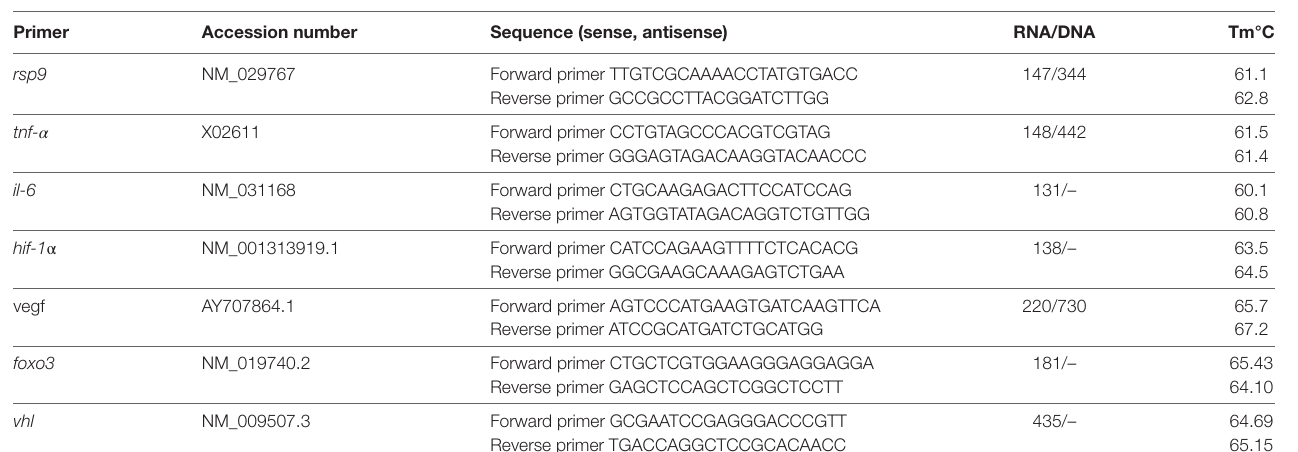
taBLe 1 | Oligonucleotide primers used in